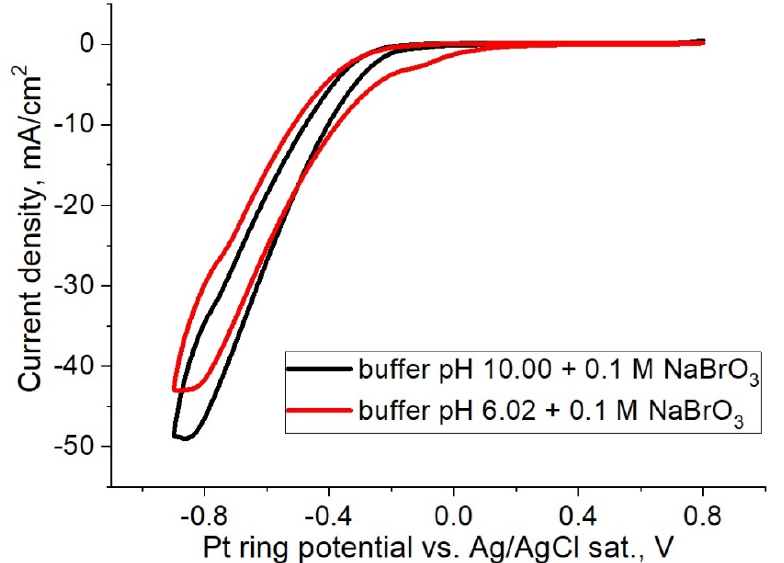
Figure 3. Cyclic voltammograms of NaBrO 3 in buffer solutions with pH = 6.02 and pH = 10, recorded on a stationary platinum electrode at a scan rate of 50 mV/s.